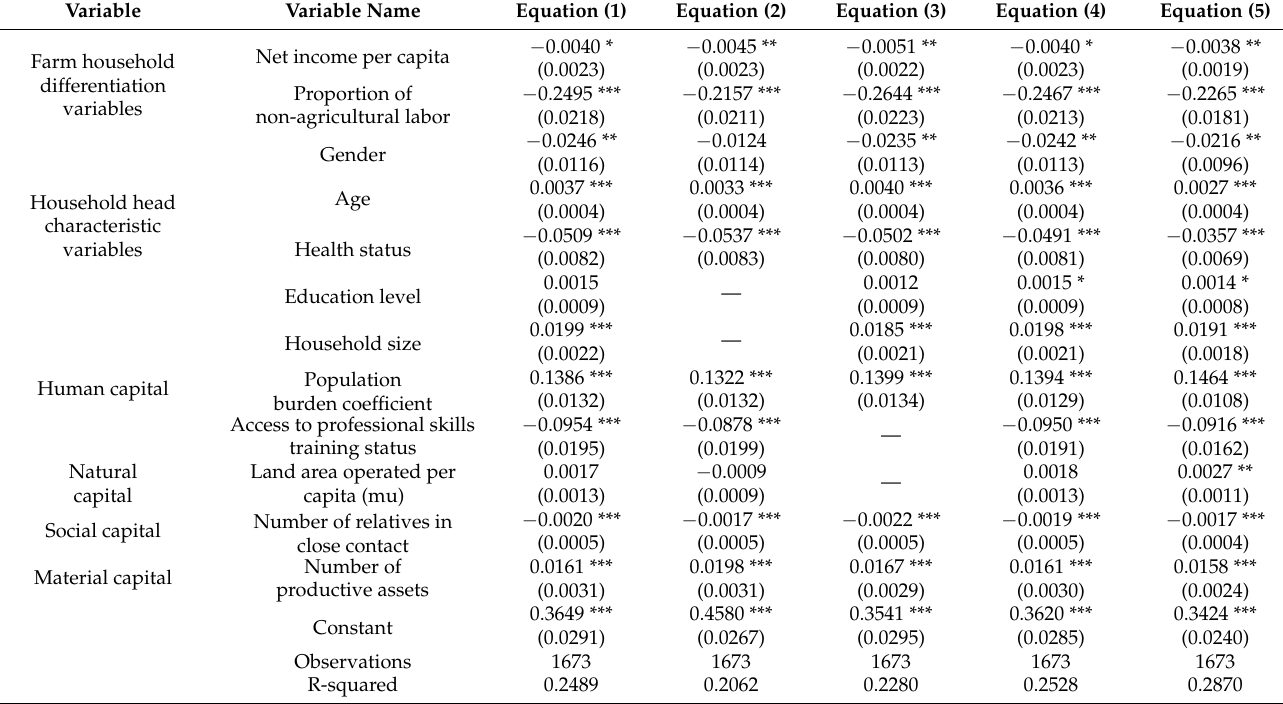
Table 2. Model estimation results and robustness